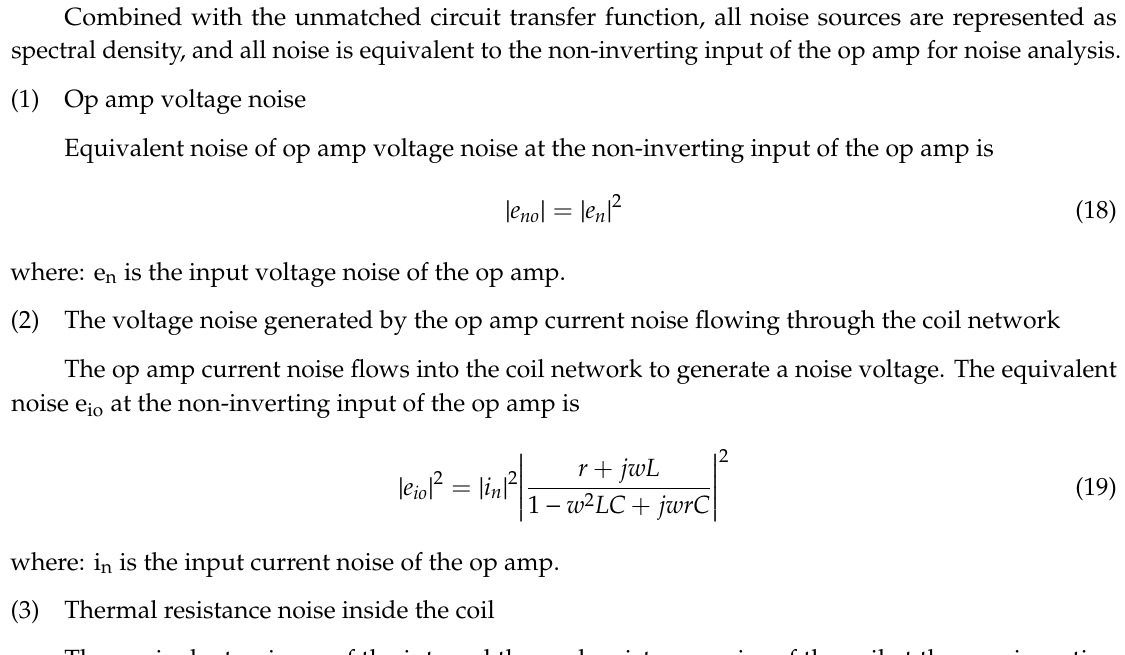
Figure 8. Coil model without matching resistor.